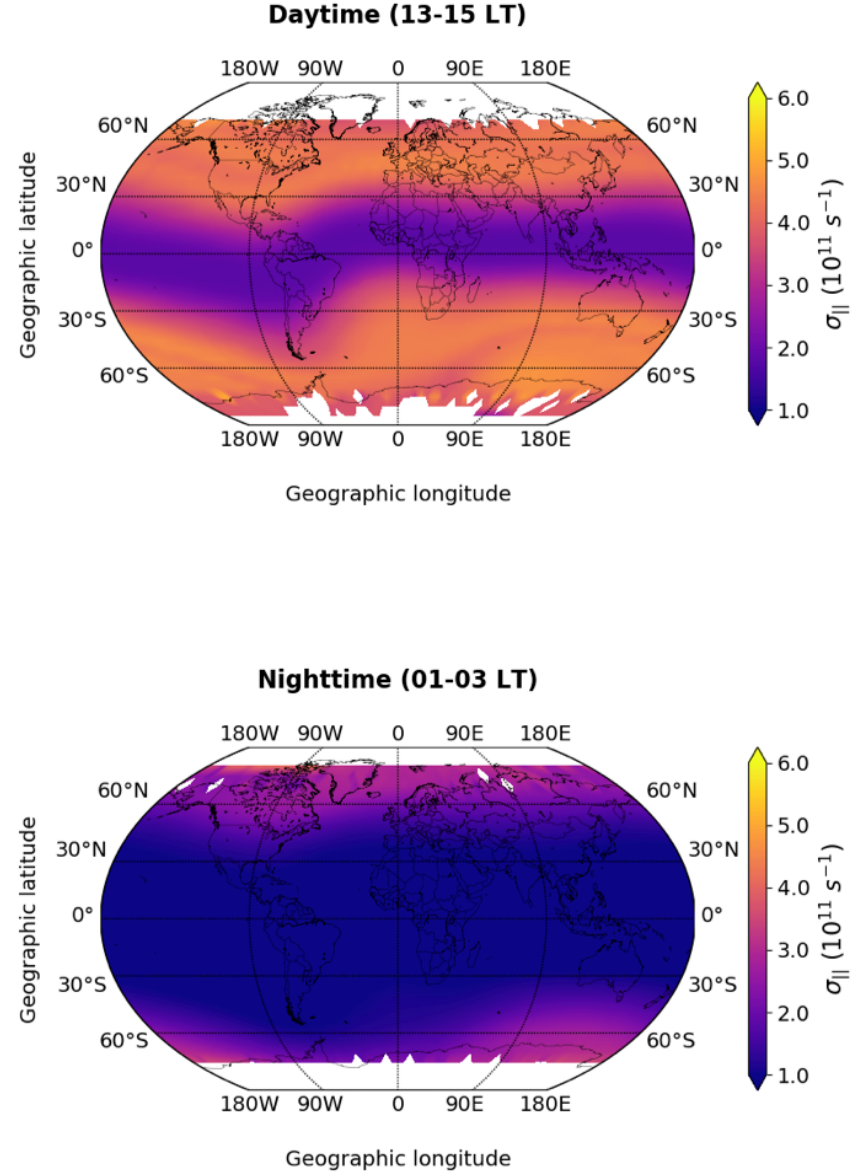
Figure 3. Maps in geodetic coordinates of σ || in the daytime ( top panel) and in the nighttime ( bottom panel) derived from IRI modeled data. The values within each bin are saturated between 1.0 × 10 11 s − 1 and 6.0 × 10 11 s − 1